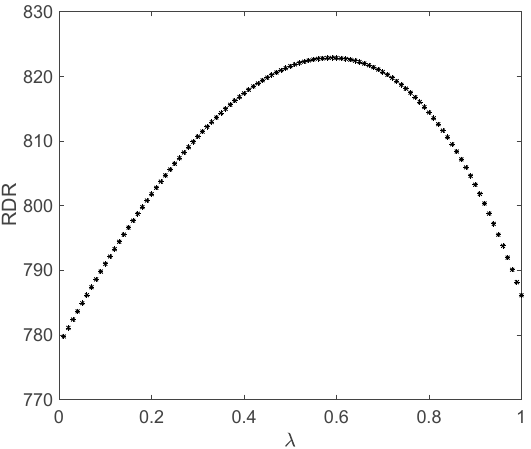
Figure 6. RDR vs. 𝜆 for example 1 . Figure 6. RDR vs. λ for example 1.